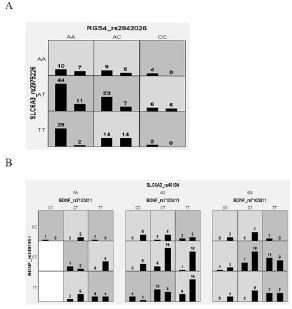
Figure 2. Distribution of high risk (dark shaded) and low risk (light shaded) genotypes of best models among the studied polymorphisms. Left bars illustrates distribution of complete responders and right bars shows incomplete responders for each genotype combination in (A) low severity and (B) high severity of illness patients with schizophrenia.